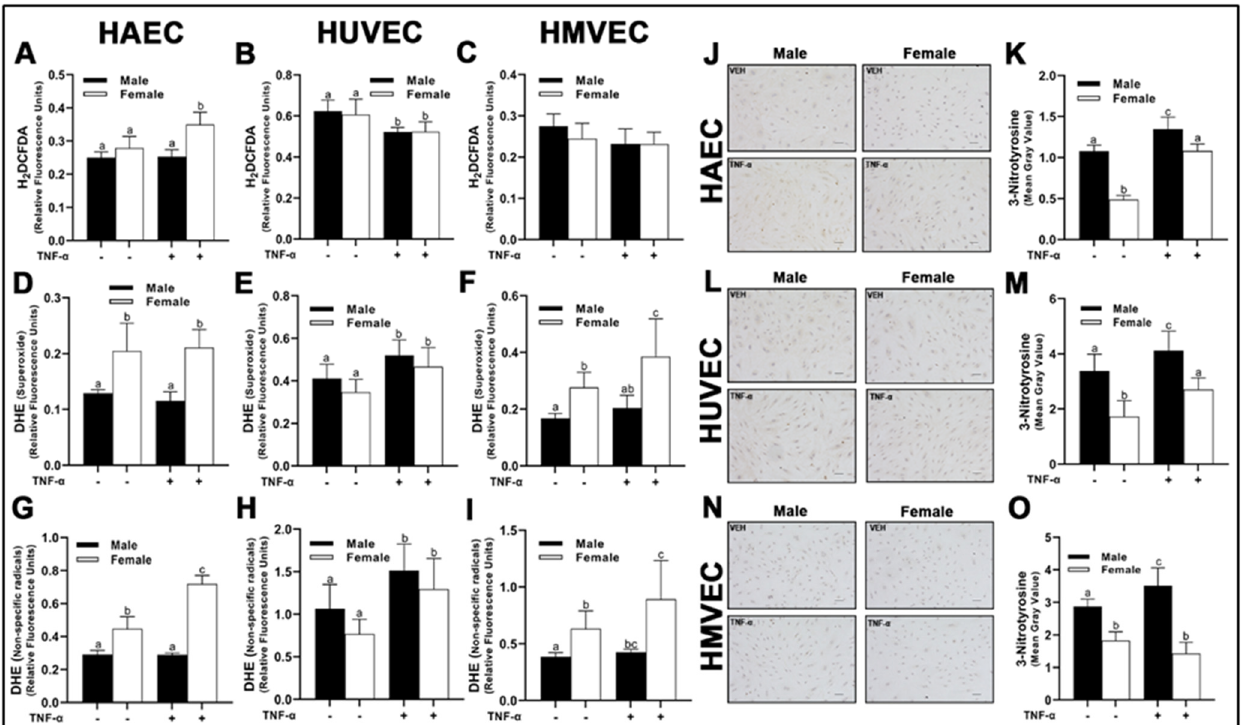
Figure 8. Redox activity in male and female endothelial cells. HAECs, HUVECs and HMVECs were cultured at ~80% confluency for 24 h in starvation medium with or without TNF- α (20 ng/mL). H 2 DCFDA or DHE dissolved in dimethyl sulfoxide were added to wells (10 μ M final concentration) followed by 30 min incubation (37 °C and 5% CO 2 ). Phenol red-free starvation medium supplemented with NucBlue™ (1 drop/mL) was added. Fluorescence was read at the following Ex/Em: 495/527 ( A – C ; H 2 DCFDA), 518/606 ( D – F ; DHE; O 2 − ) 480/576 ( G – I ; DHE; non-specific radicals) and 360/460 (Hoechst 33342 with NucBlue™). Fluorometric values for H 2 DCFDA and DHE were nor- malized to Hoechst 33342. Cells were also fixed on poly-L-lysine cover slips and stained with DAB diluent following incubation with nitrotyrosine primary antibody ( J – O ). Quantification was per- formed with Image J. The scale bar is 50 μ m and objective magnification is 20×. Data are expressed as mean ± SD from 3–6 experiments. Data were statistically analyzed with one-way ANOVA fol- lowed by Tukey post hoc multiple comparison analysis between groups. Values that do not share the same letter are significantly different from each other ( p ≤ 0.05).